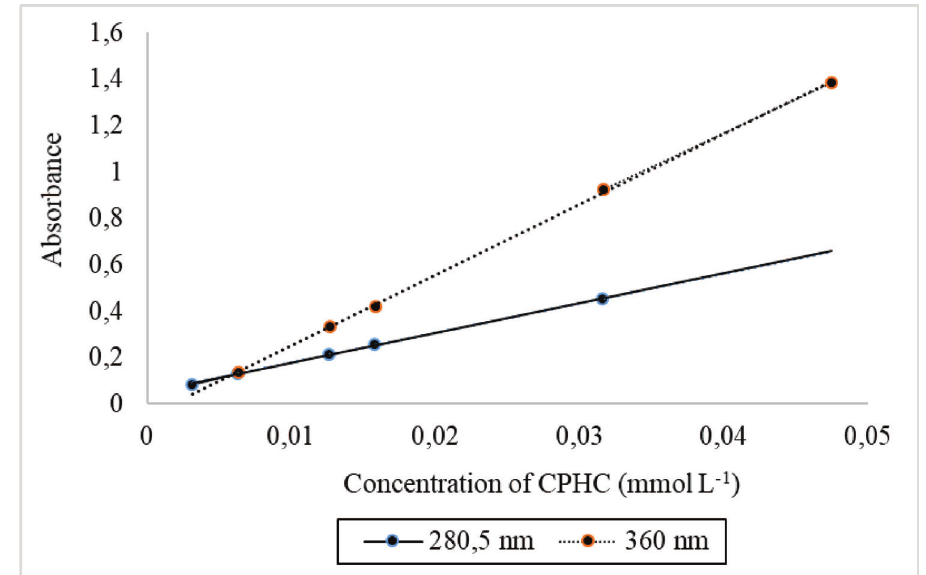
FIGURE 5 - Absorbances versus concentration.